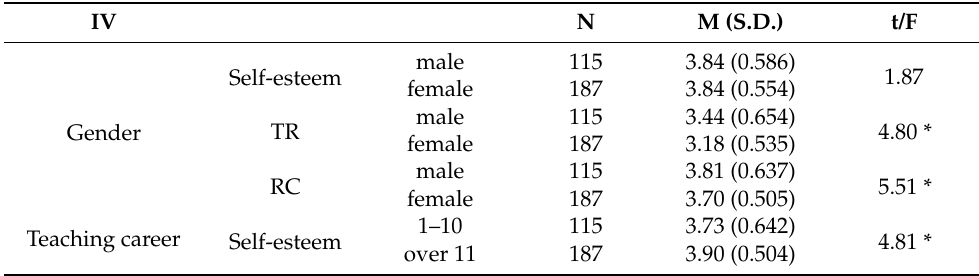
Table 1. Differences according to sociodemographic